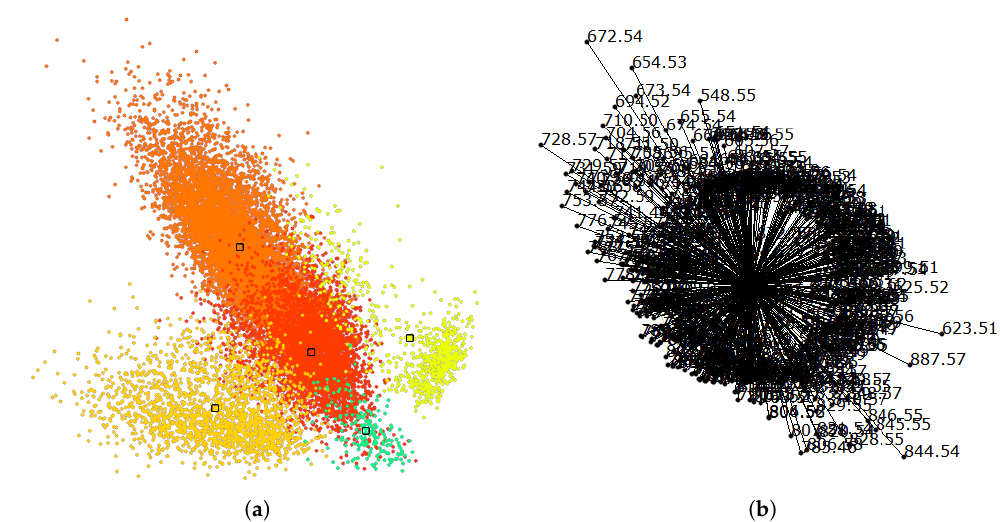
Figure 13. Mouse cerebellum in positive ion mode data set [9]: ( a ) Linear embedding of labeled data, where color-coded labels correspond to interactively generated clusters and respective regions in Figure 12f. ( b ) Corresponding SC configuration.